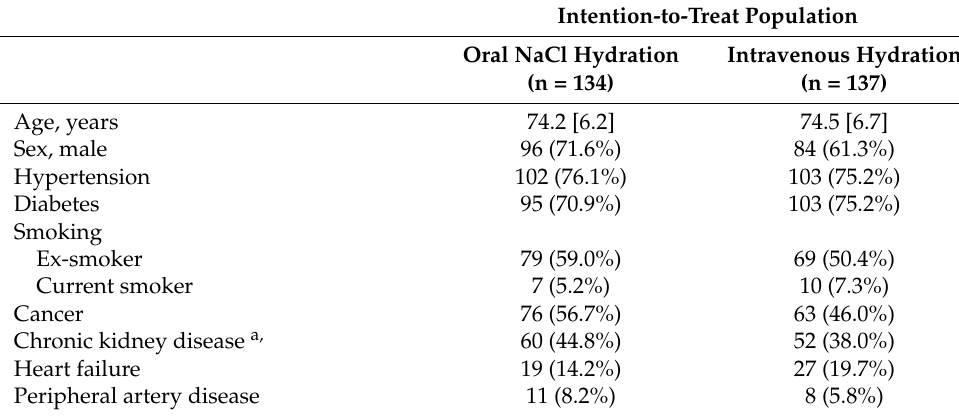
Table A1. Patient characteristics at inclusion in the study (intention-to-treat